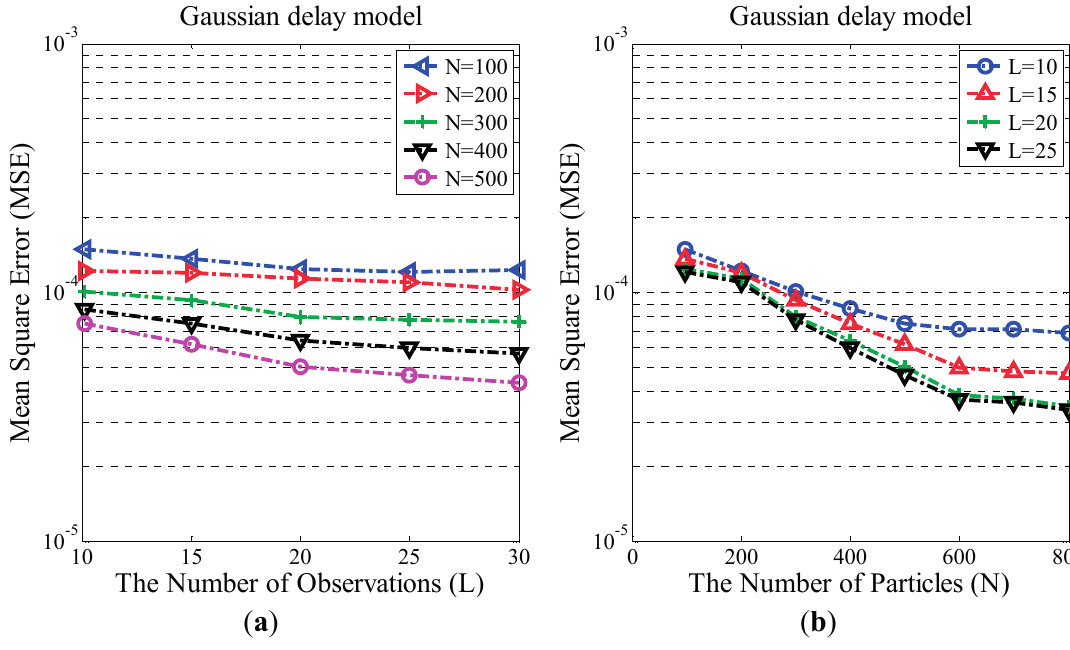
Figure 5. ( a ) The relationship between the Number of Observations and MSE; ( b ) The relationship between the Number of Particles and